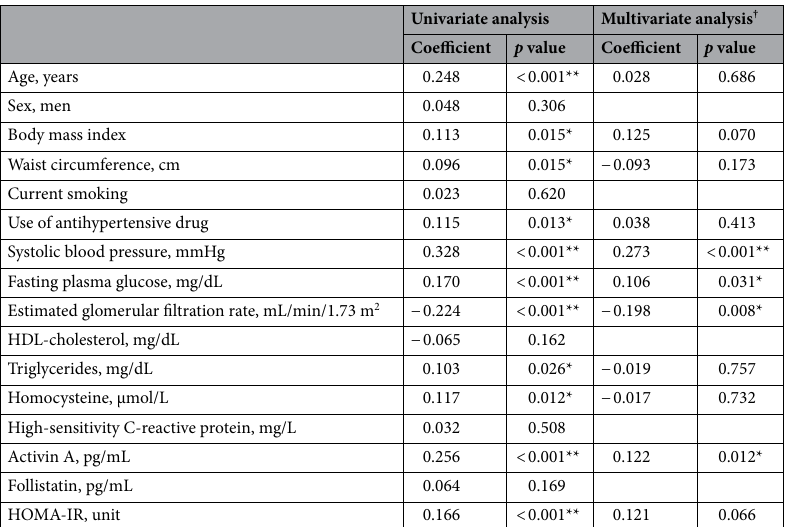
Table 2. Univariable and multivariable associations with log urine albumin-to-creatinine ratio (LogUACR). *p < 0.05, ** p < 0.001. † The multivariate regression model included all available variables with a p-value < 0.100. eGFR estimated glomerular filtration rate, hs-CRP high-sensitivity C-reactive protein.